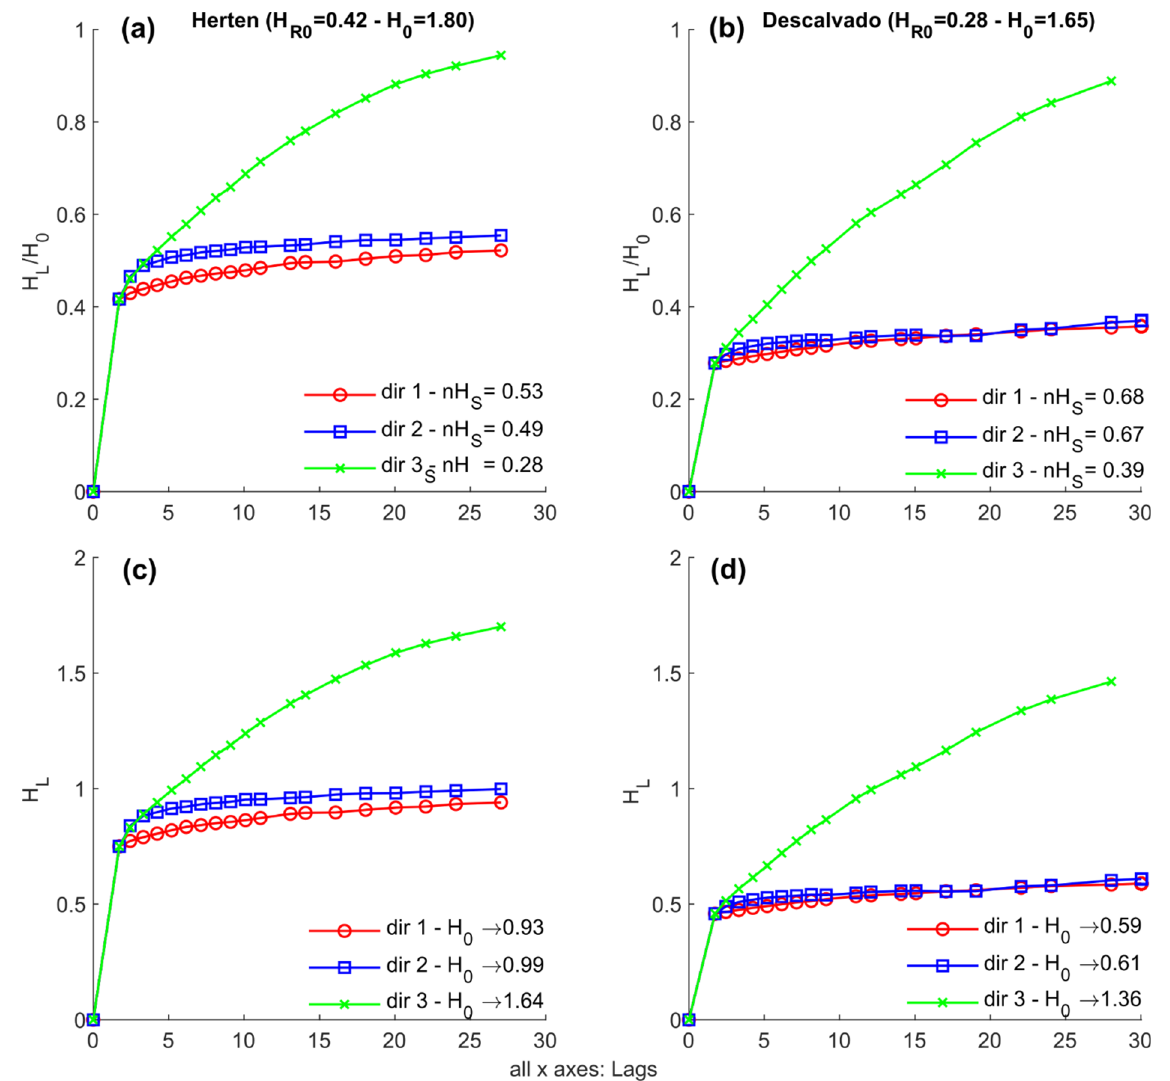
Figure 11. Entrograms and corresponding statistics calculated using GEOENT for each of the four analysed analogues. ( a ) Normalized entrograms for the Herten analogue; ( b ) normalized entrograms for the Descalvado analogue; ( c ) Not ‐ normalized entrograms for the Herten analogue; ( d ) Not ‐ normalized entrograms for the Descalvado analogue.